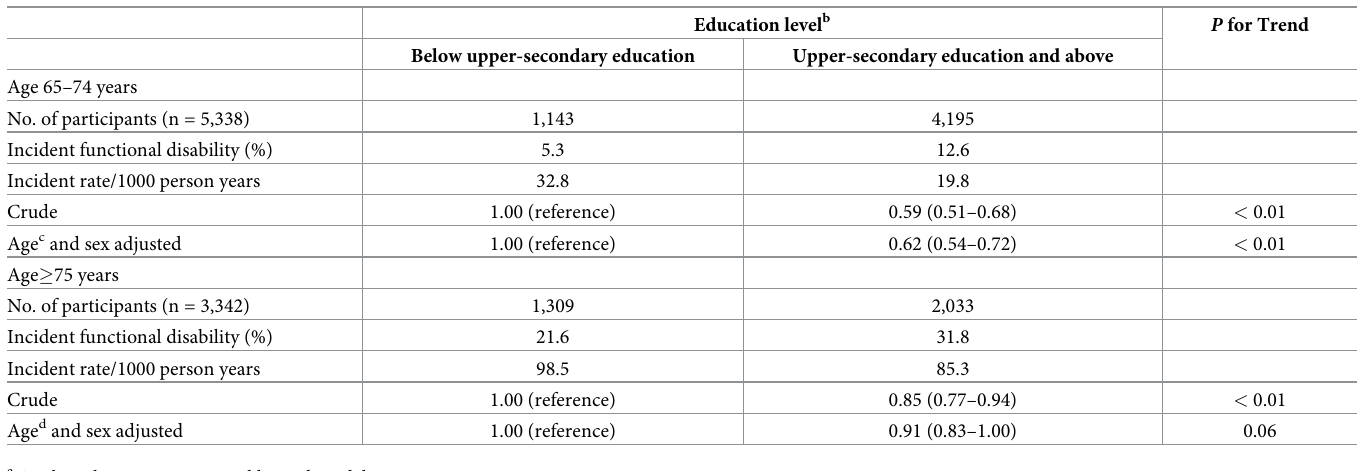
We used an accelerated failure time model and a logistic regression model to estimate the natural direct effect, natural indirect effect, and total effect. A “proportion mediated” was cal- culated as the ratio of the natural indirect effect to the total effect. We observed that participa- tion in community activities contributed moderately (34.7%) to the relationship between education level and incident functional disability. In a prior study that analyzed mediators in the relationship between education and health in terms of disability, those explained by social participation ranged from 27.4% to 41.8% in the middle-higher education group, which was similar to our present results [15]. Table 3. Relationship between education level and incident functional disability by age. Ohsaki city, Japan, 2006–2015 (n = 8,680) a